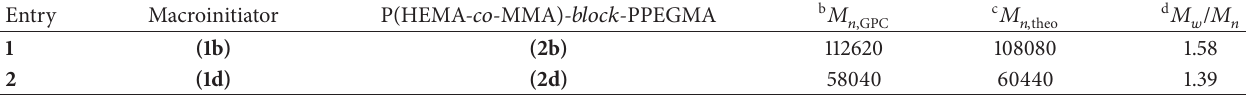
Table 3: Conditions a and results for the synthesis of P(HEMA- co -MMA)- block